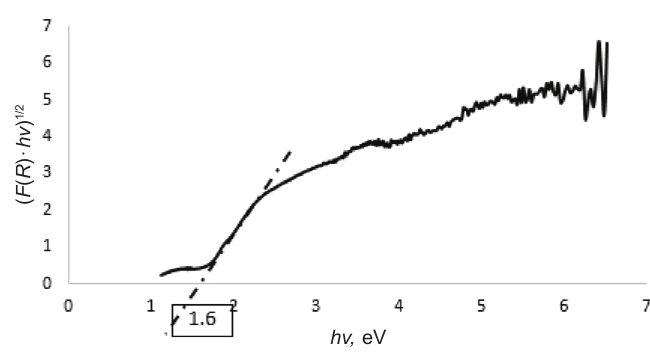
Fig. 3 – UV-Vis DRS analysis of TiO